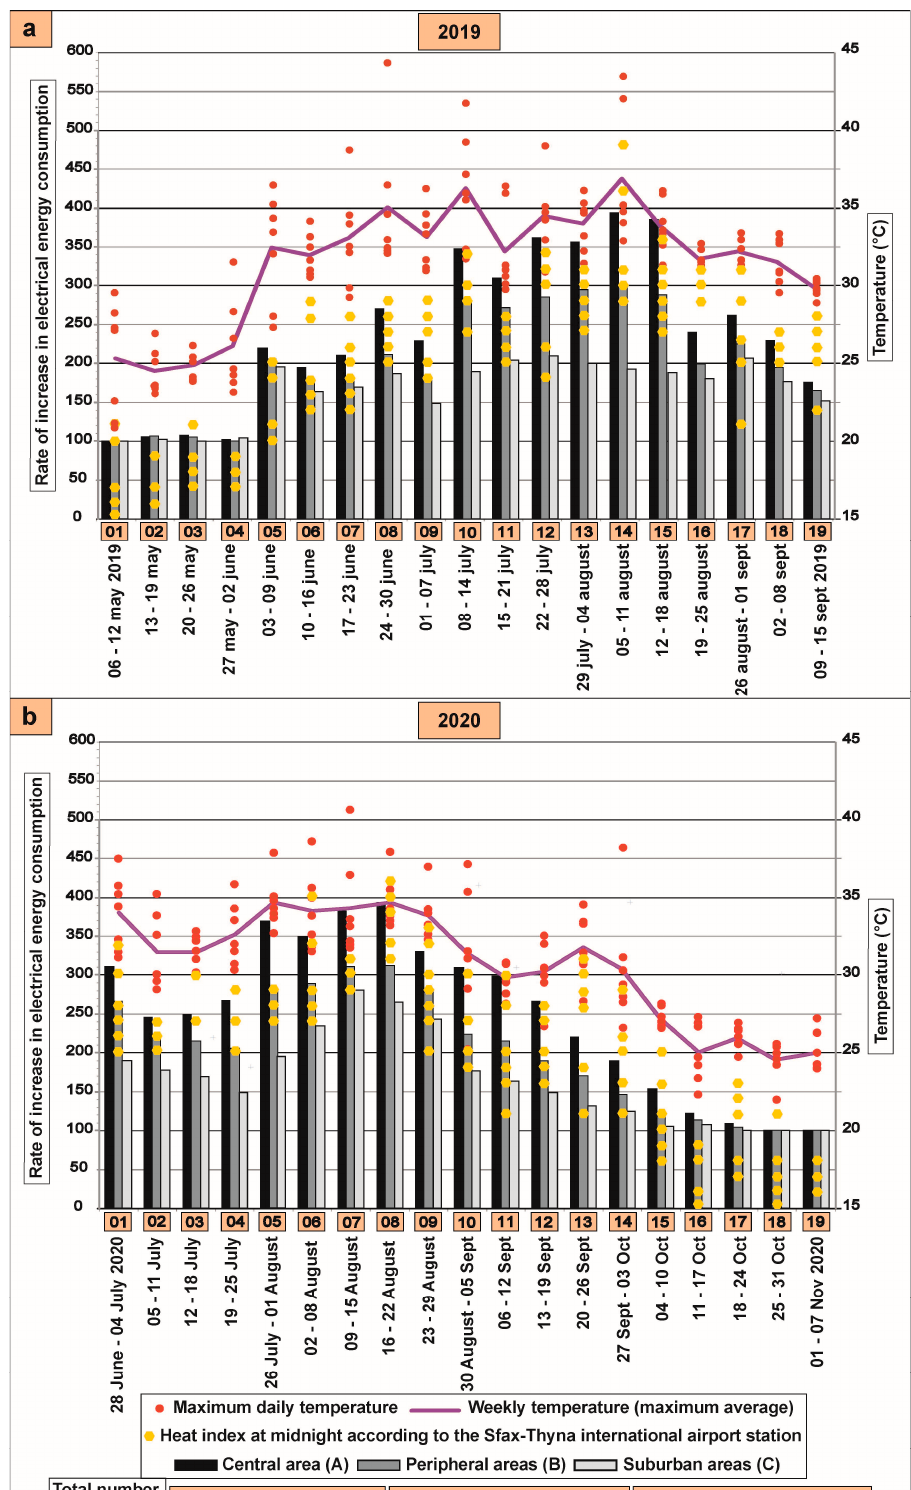
Figure 6. ( a ) Weekly average increase in energy consumption for air conditioning calculated between 6 May and 15 September 2019; ( b ) weekly average increase in energy consumption for air conditioning calculated between 28 June and 7 November 2020. The daily maximum temperatures and weekly maximum averages were recorded and calculated during the same periods as the weekly consumption monitoring mentioned above.